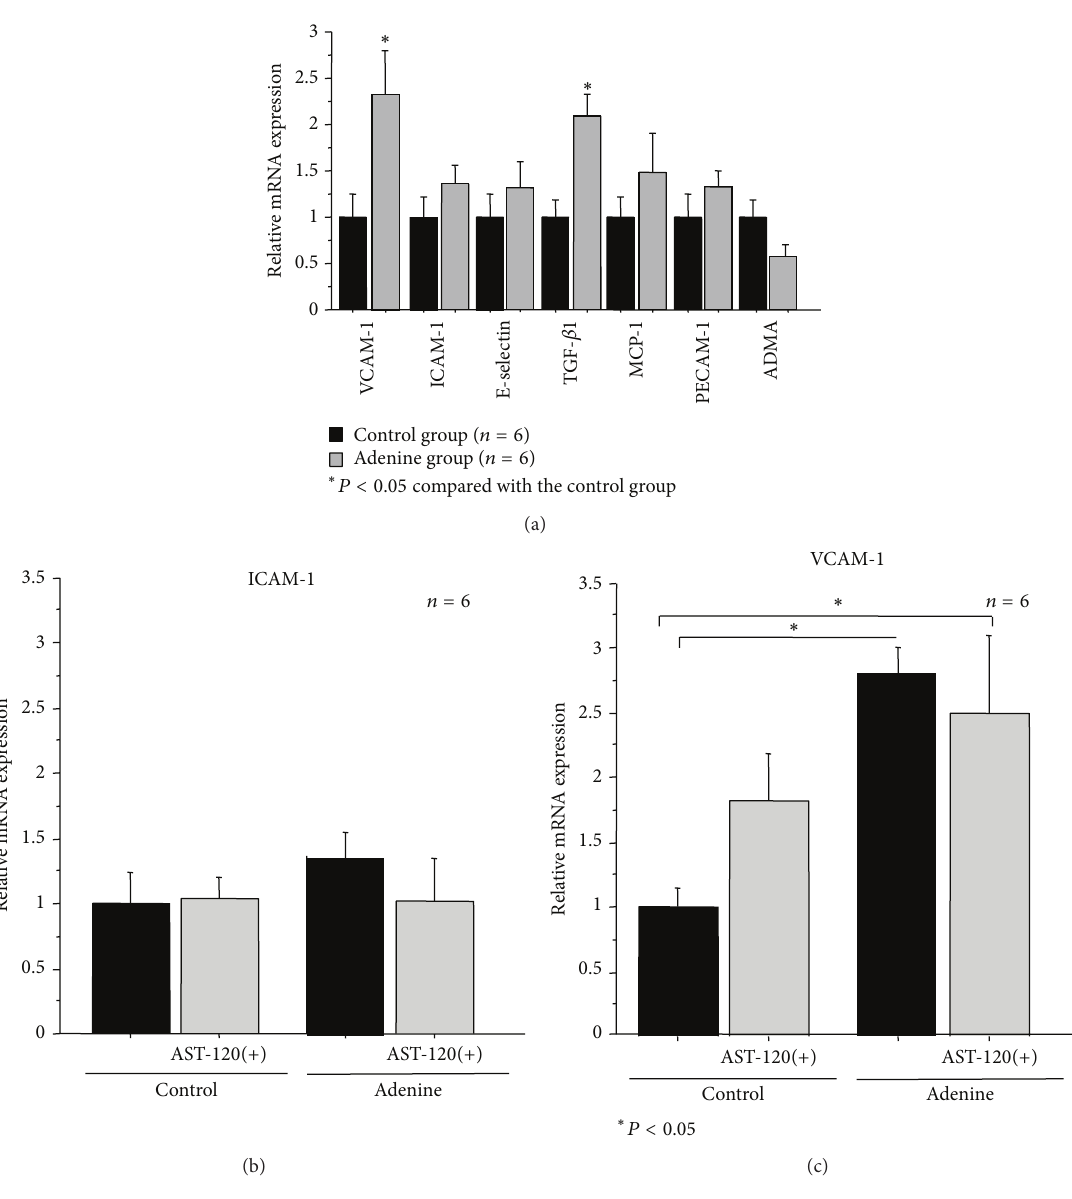
Figure 4: Expression of adhesion molecules, growth factors, and endothelial dysfunction factor. Levels of ICAM-1, VCAM-1, TGF- 𝛽 1, MCP- 1, E-selection, PECAM-1, and ADMA mRNA in thoracic aorta were determined in the control and adenine rats at 7 weeks. (b) and (c): expressions of ICAM-1 and VCAM-1 mRNA in thoracic aorta. Quantitative RT-PCR of ICAM-1 and VCAM-1 using RNA extracted from the thoracic aorta in the control, control + AST-120, adenine, and adenine + AST-120 groups ( 𝑛 = 6 ). The relative mRNA level was calculated with the level of the control group set at 1. Data are expressed as mean ± SD of five rats in each group. effect of AST-120 on the development of atherosclerosis in early stage of CKD was examined in adenine-induced uremic rats. This study revealed that the number of adherent mononuclear cells was increased in uremic condition and indicated significant relation with IS and creatinine in